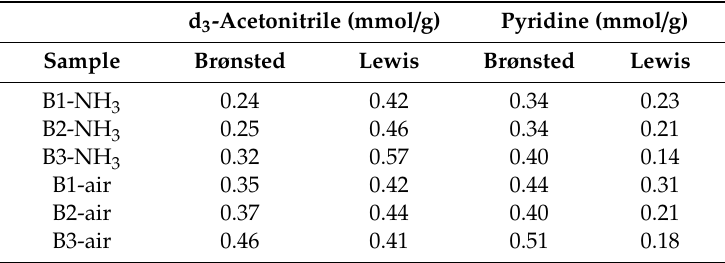
Table 3. Results of d 3 -acetonitrile (10 Torr, 30 min adsorption / desorption at RT) and pyridine (10 Torr, 30